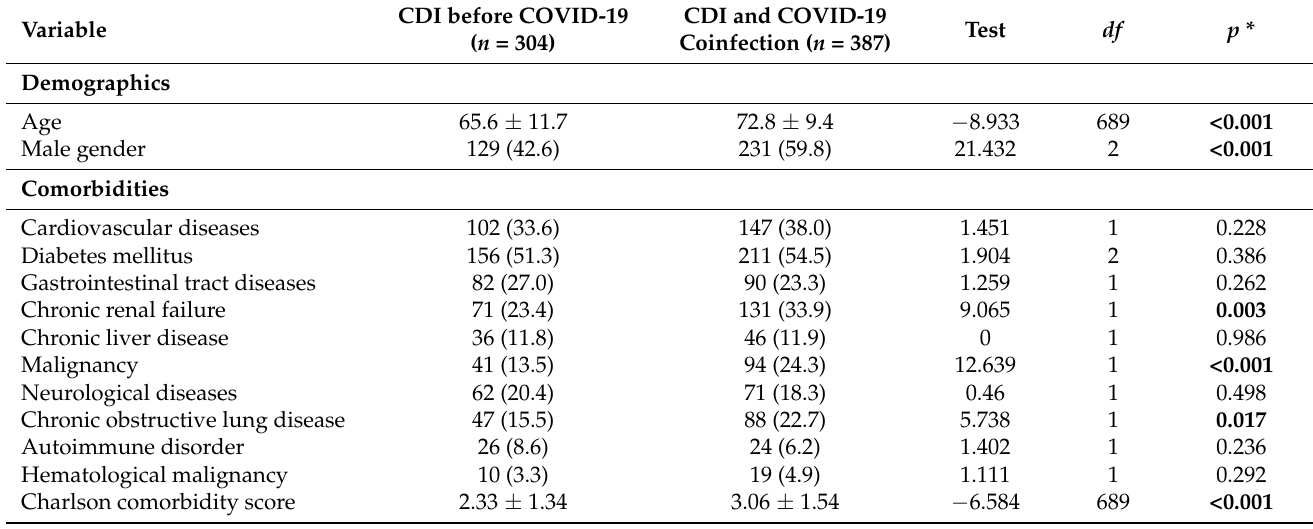
Table 1. Demographic characteristics, previous and concomitant medication use, laboratory param- eters at the time of CDI diagnosis, as well as the outcome of treatment in the examined groups of